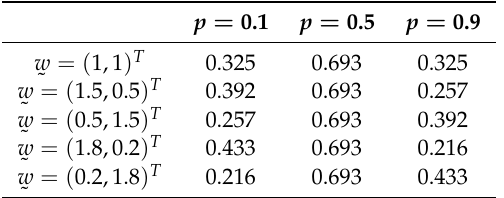
Table 1. The Weighted Shannon Entropy for X ∼ B ( 1, p )